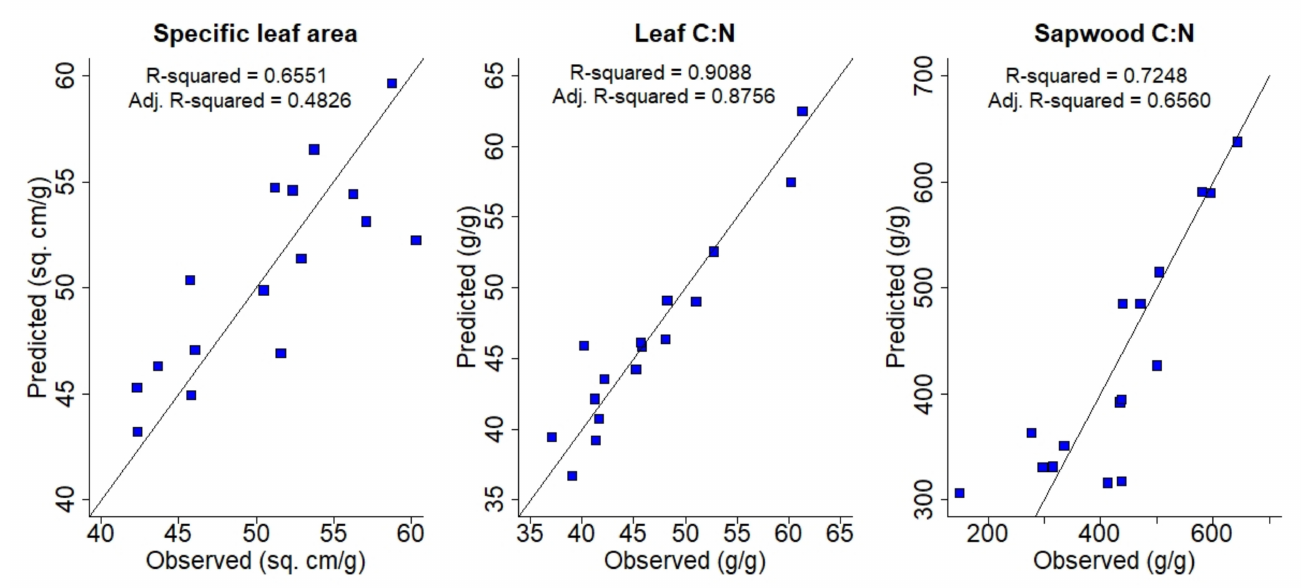
Figure 3. Relationships between observed traits (see also Table S3) and predicted values with models shown in Table